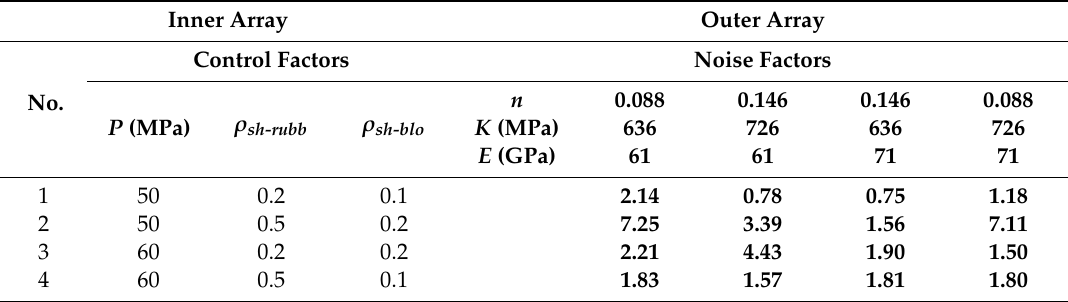
Table 3. Results of the elastic recovery d (mm) obtained from the simulation by the FEM (the results are represented in the values in bold). Inner Array Outer Array